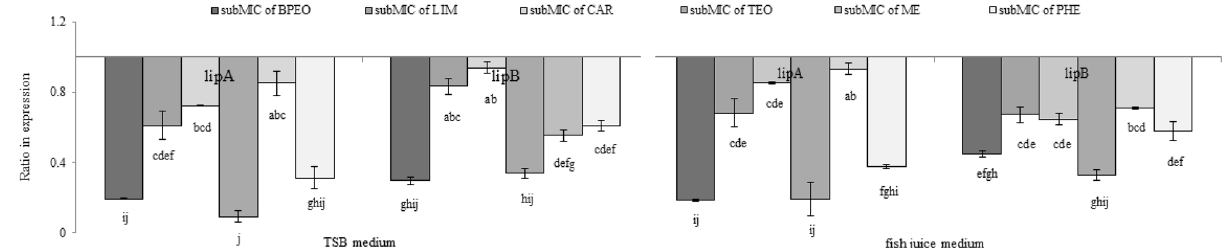
Figure 8. Ratio in expression of lipA and lipB genes in P. psychrophila KM02 grown on modified TSB and fish juice medium supplemented with subMICs of black pepper (BPEO) and tarragon essential oils (TEO), limonene (LIM), β-caryophyllene (CAR), methyl eugenol (ME), and β-phellandrene (PHE). Values are calculated from three independent replicates. Error bars represents standard deviation values. The same letter indicates not statistically differences in expression as provided by Tukey’s test after ANOVA analysis (F = 41.97, p < 0.05).